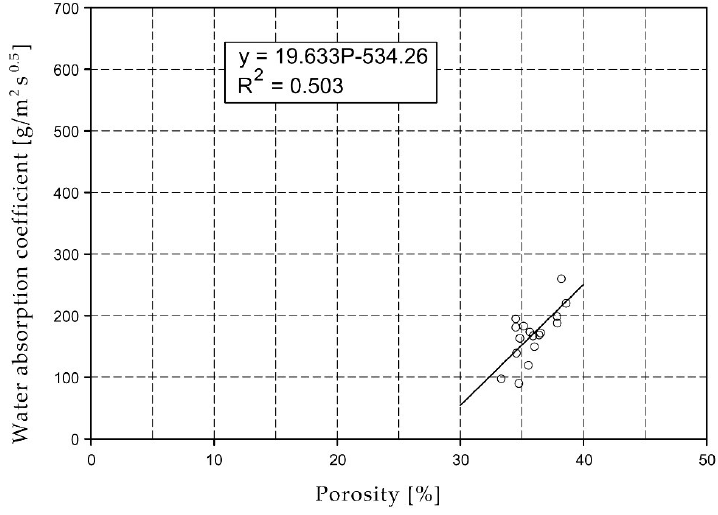
Figure 14. Compressive strength of N01XXI series bricks.